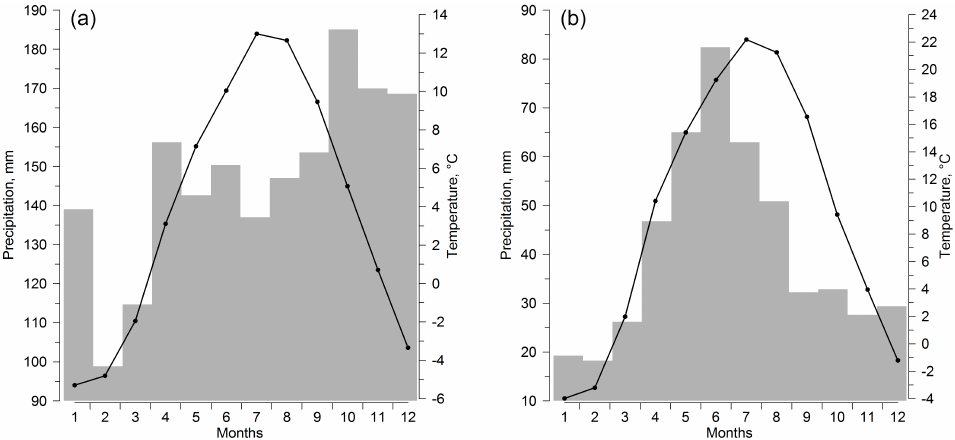
Figure 4. Average seasonal cycle of temperature (black dots and line) and precipitation (grey bars) calculated over 1966–1990 period, (a) for the Klukhorskiy Pereval station (illustrating the lack of a distinct seasonal cycle in precipitation south of the Caucasus) and (b) for the Mineral’nyye Vody station (illustrating the clear seasonal cycle in precipitation seen in stations north of the Caucasus). Error bars (SEM) are shown for the interannual standard deviation of the monthly precipitation rate, while the same error bars for the temperature are dimensionless on the scale of the graph.